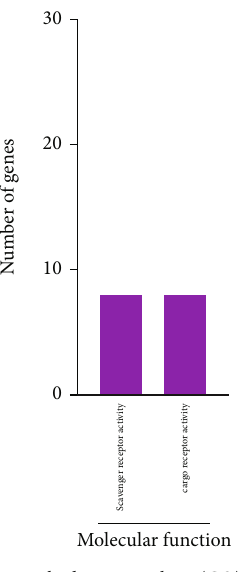
Figure 7: Signi fi cantly enriched gene ontology (GO) terms of the DEGs in Synechogobius hasta muscle. Top signi fi cantly enriched GO terms for DEGs in the comparison of MS vs . MC (a), ML vs . MC (b), and MS vs . ML (c). The horizontal axis denotes the number of DEGs with a signi fi cantly enriched GO term. The vertical axis represents the signi fi cantly enriched GO term. The GO terms are grouped into three categories: biological process (BP), cellular component (CC), and molecular function (MF). The size and color of the columns represent the number of DEGs with a signi fi cantly enriched GO term and the functional classi fi cation, respectively. When more than 10 enriched GO terms (corrected P ≤ 0 : 05 ) for DEGs were identi fi ed, only the top 10 signi fi cantly enriched GO terms were listed. MC: muscle in the control group (continuously fed for 14 days); MS: muscle in the starved group (starved for 3 days); ML: muscle in the starved group (starved for 14 days).